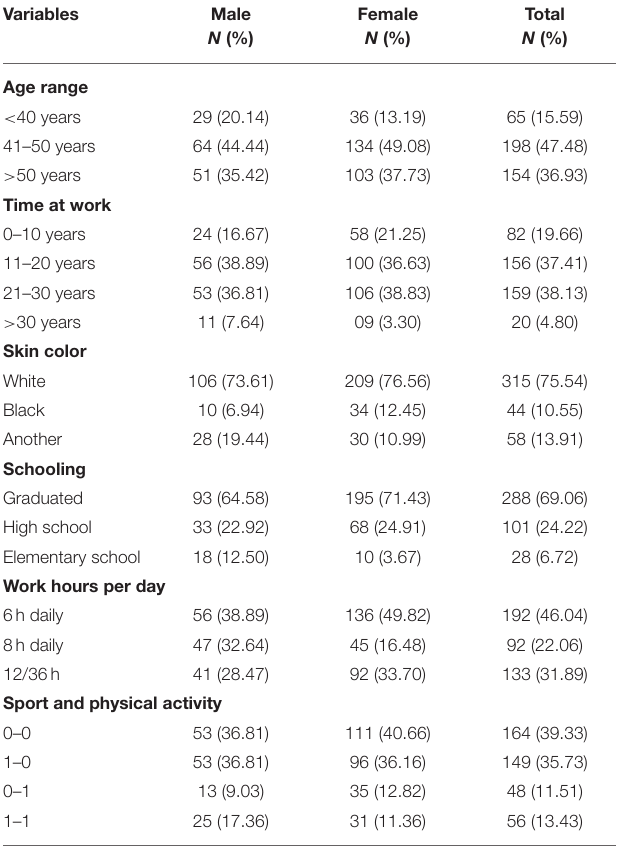
TABLE 1 | Characteristics of participating workers according to